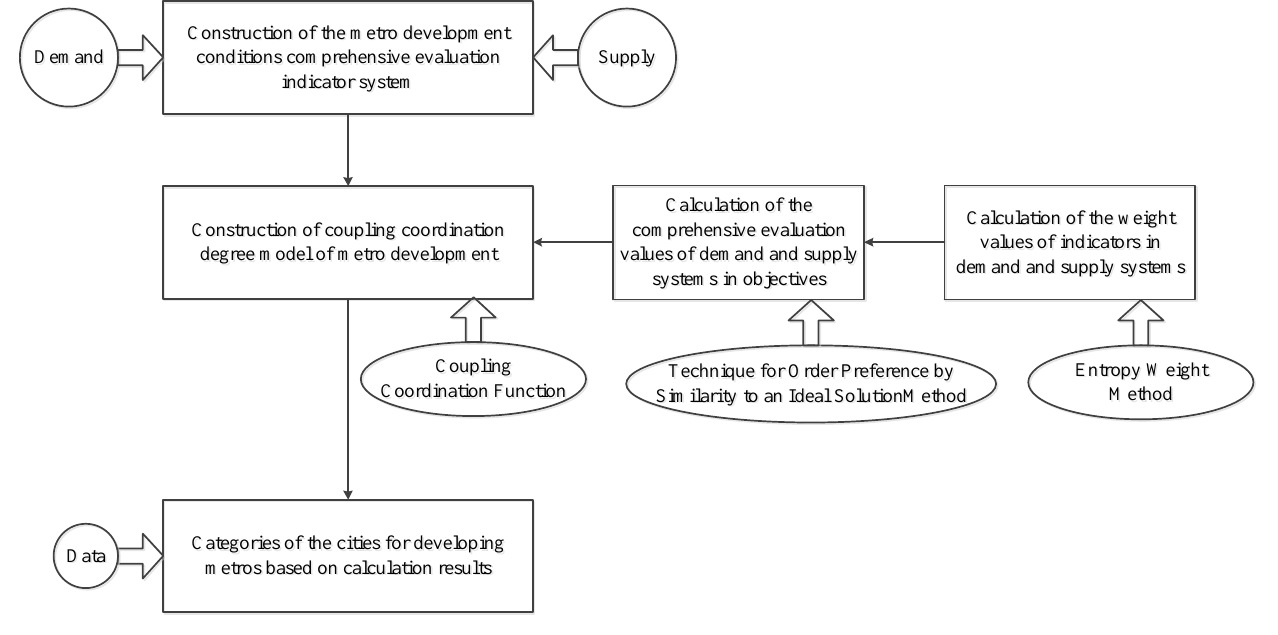
Figure 1. Producers of methodology.